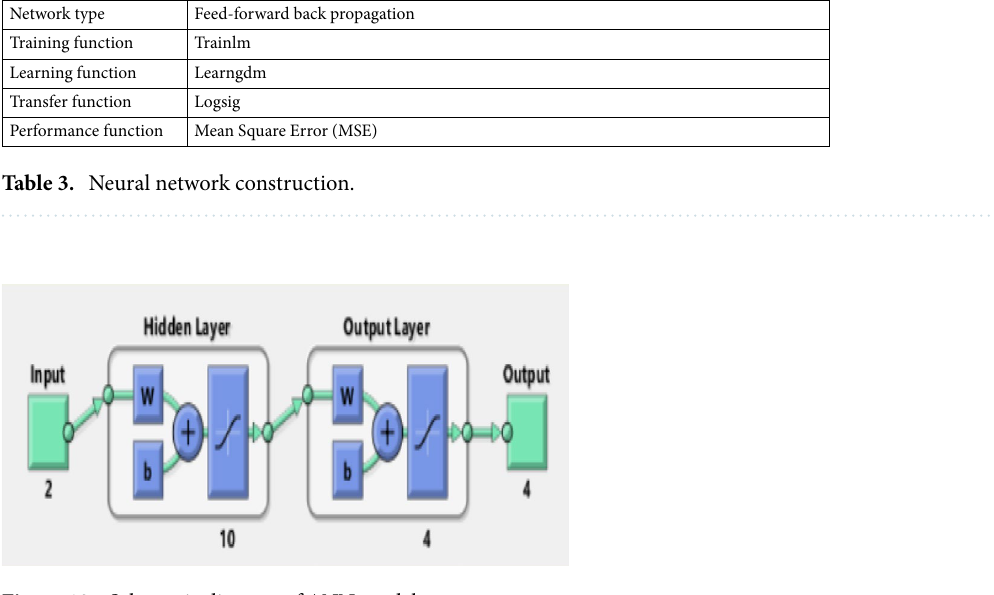
Figure 13. Schematic diagram of ANN